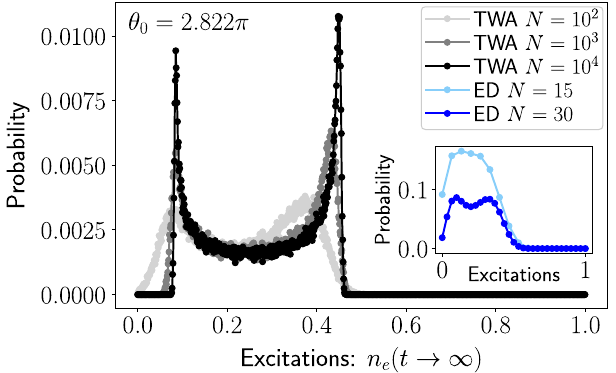
FIG. 18. Distribution of excitations. Results for the six-level 1 = 2 ; 3 = 2 Þ starting in j g ; F system ð F − 1 = 2 i V and being g e Þ ¼ ð ˆ R (cid:2) excited by an drive with pulse area θ 0 ¼ 2 . 822 π . The system starts at a maximum of V ð θ Þ ; see Fig. 8(a). The main plot shows a histogram of the excited-state population n obtained with TWA e by simulating 10 5 trajectories and binning the results over a window of width 0.001. The results for different N (gray-black lines) show a clear double-peak structure peaked at the n of the e dark states left and right of θ 0 ¼ 2 . 822 π in V ð θ Þ . The inset shows the histogram of n obtained with ED simulations for small e systems with N ¼ 15 and N ¼ 30